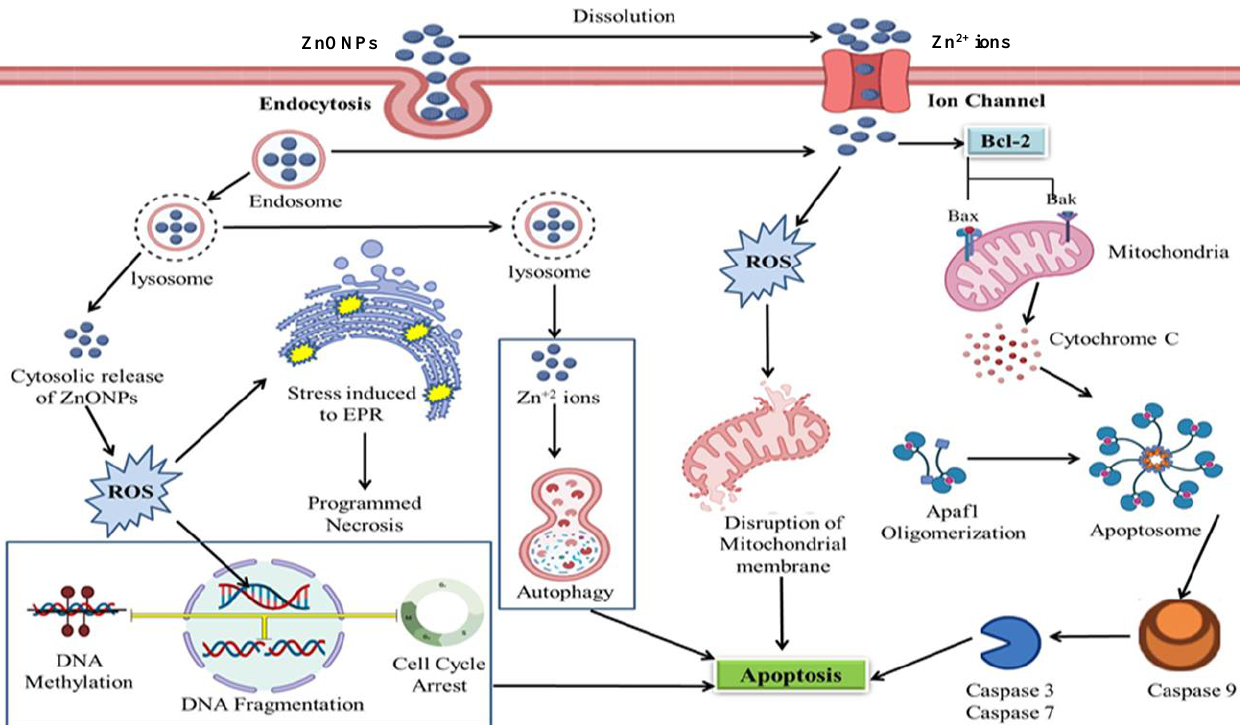
Figure 5. Possible mechanism involved in anticancerous activity of ZnO NPs.